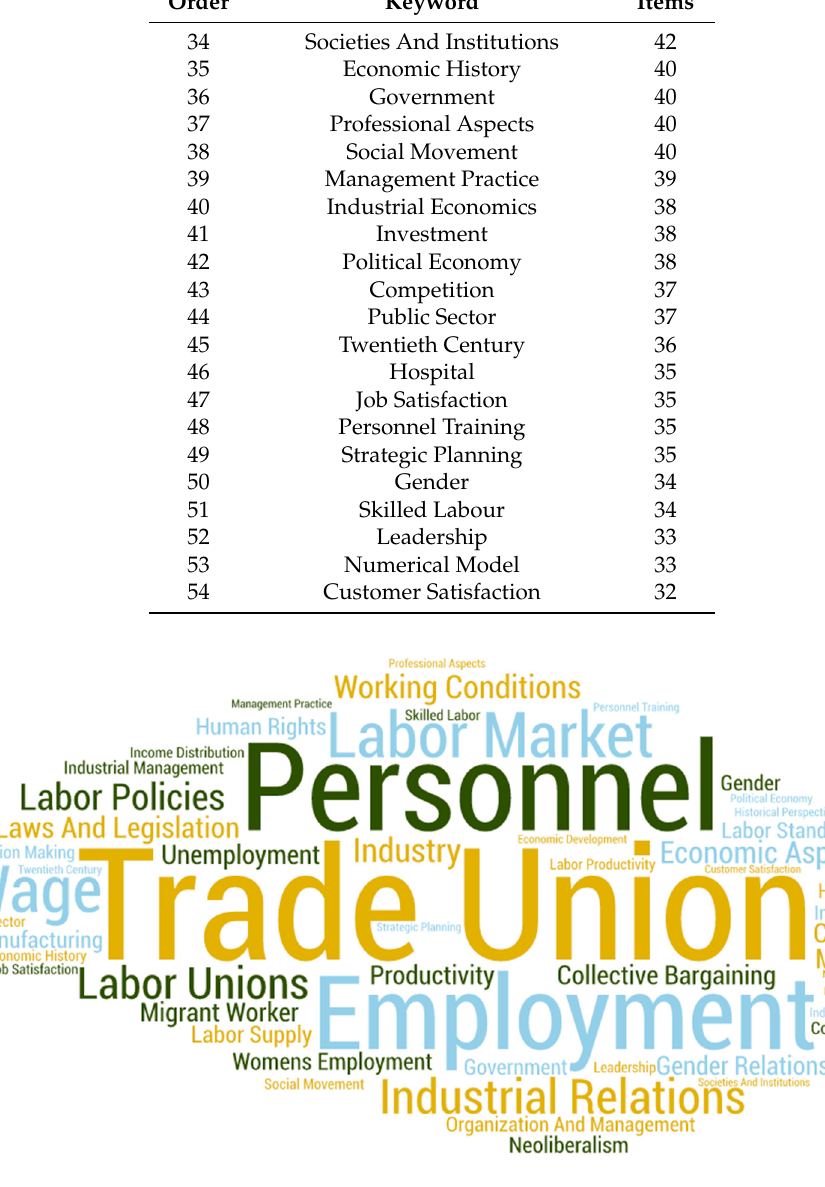
Figure 9. Cloud word based on the main keywords related to labour relations worldwide research.